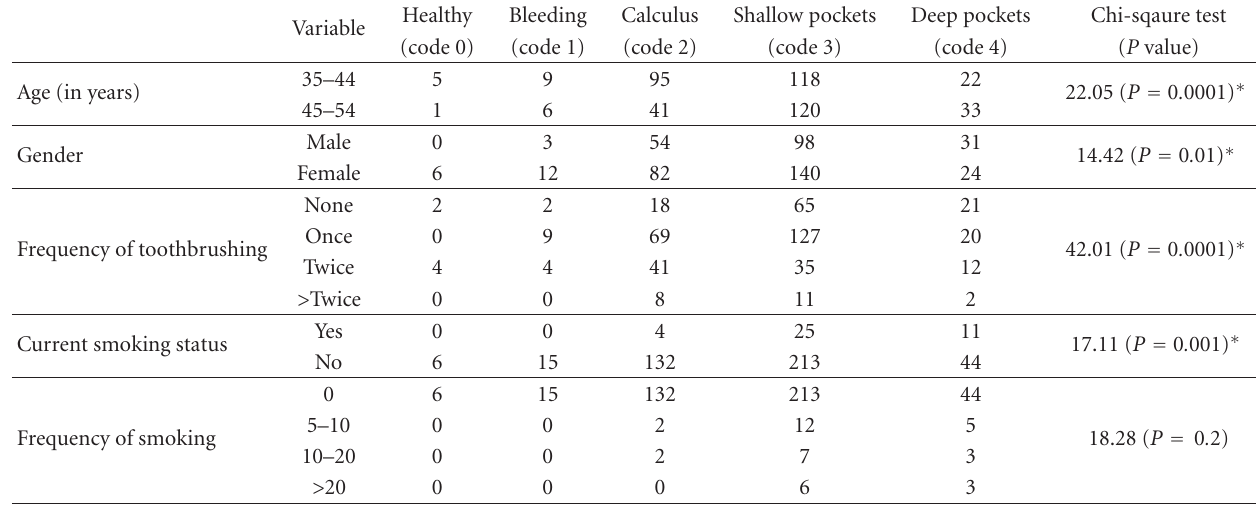
Table 1: Number of subjects as per the CPI codes for di ff erent variables.